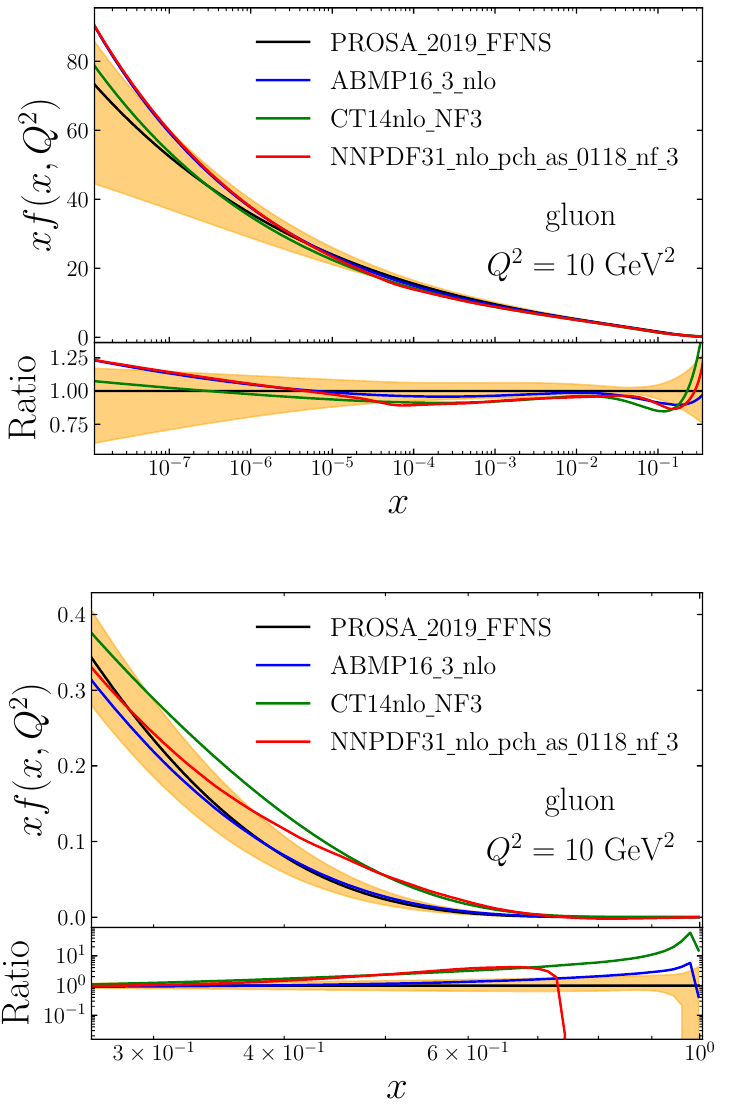
Figure 8. Gluon PDFs xf ( x, Q 2 ) for Q 2 = 10 GeV 2 for x < 0 . 3 (upper) and x > 0 . 3 (lower) for the PROSA 2019 FFNS fit (black curve with orange uncertainty band). The ABMP16, CT14 and NNPDF3.1 central gluon PDFs are also shown. All PDFs are for 3 active flavours at NLO. The lower insets show ratios relative to the central PROSA PDF. Note the different scales in the two ratio